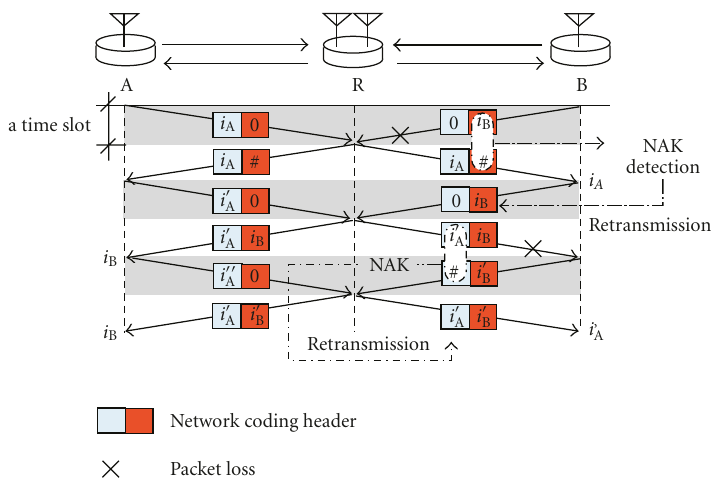
Figure 10: Proposed retransmission scheme for two-way relay ( L = 1).